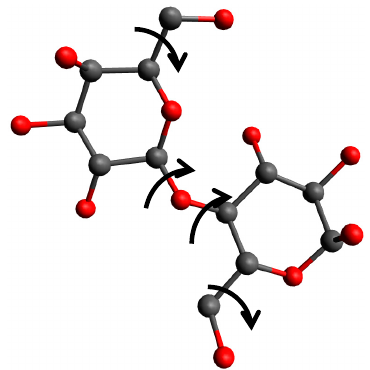
Figure 1. The molecular model for D-lactose; hydrogen atoms are not shown. The four variable torsion angles are indicated. C atoms are shown in gray and O atoms in red.